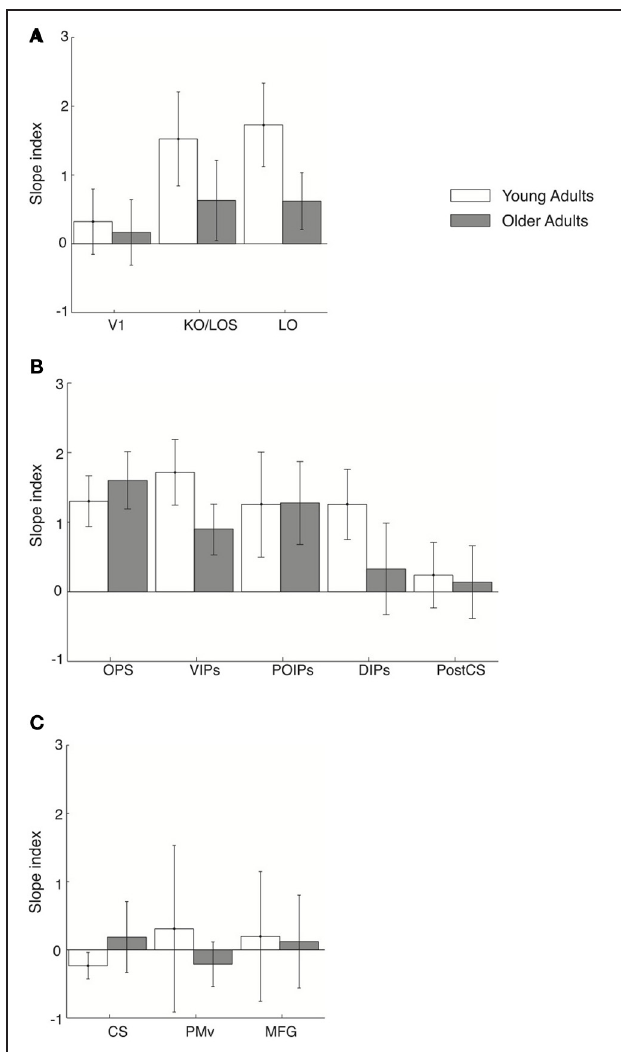
FIGURE 6 | Slope index for fMR-metric functions: control experiment. Slope index (difference in the slope of the fMR-metric functions between pre- and post-training sessions) is plotted for young (white) and older adults (gray) performing the control (target letter detection) task. ROIs are grouped together by lobe, (A) occipital (B) parietal (C) frontal. Error bars indicate the 95% confidence interval calculated using a bootstrap procedure.